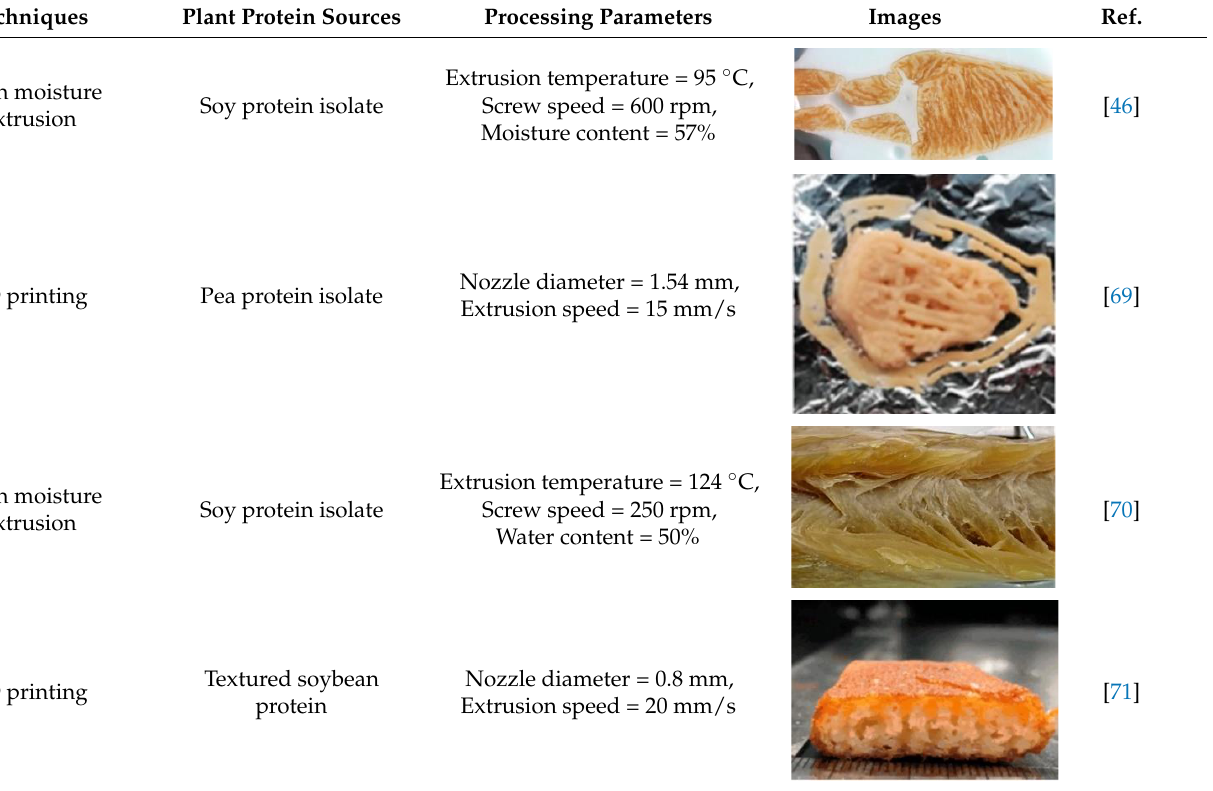
Table 5. Plant-based meat analogues with different processing techniques. Processing Parameters Images